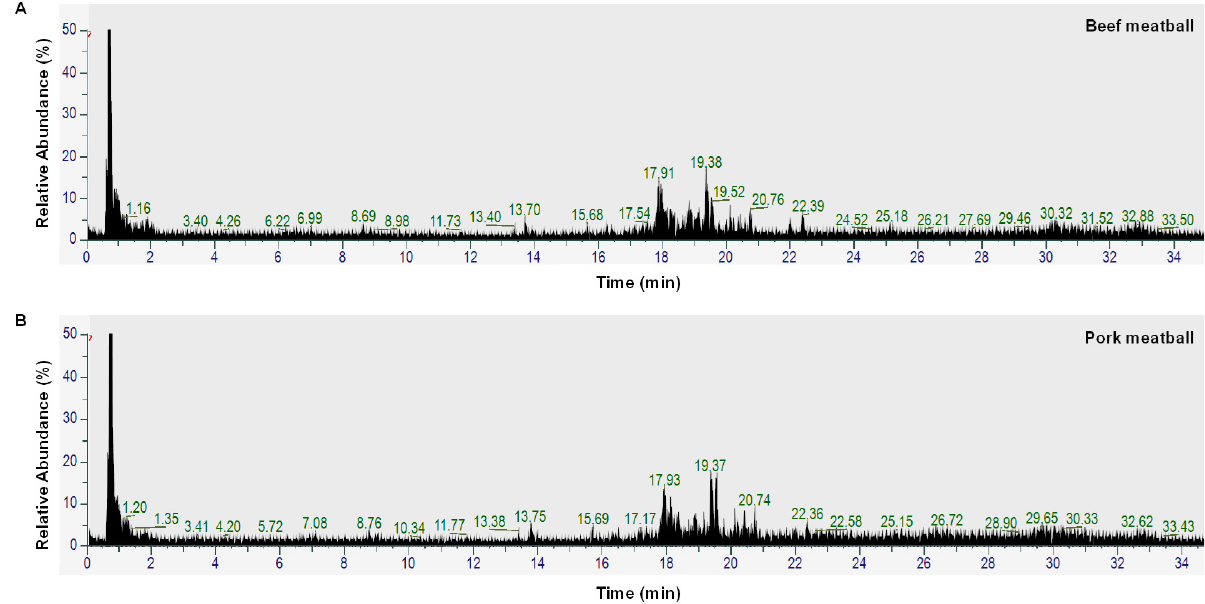
Figure 1. Total ion chromatogram (TIC) of a beef meatball ( A ) and a pork meatball ( B